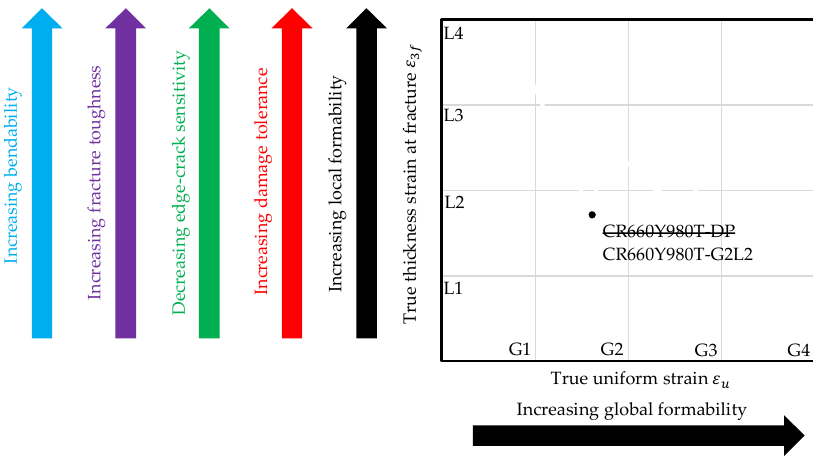
Figure 12. Designation on basis of global and local formability.